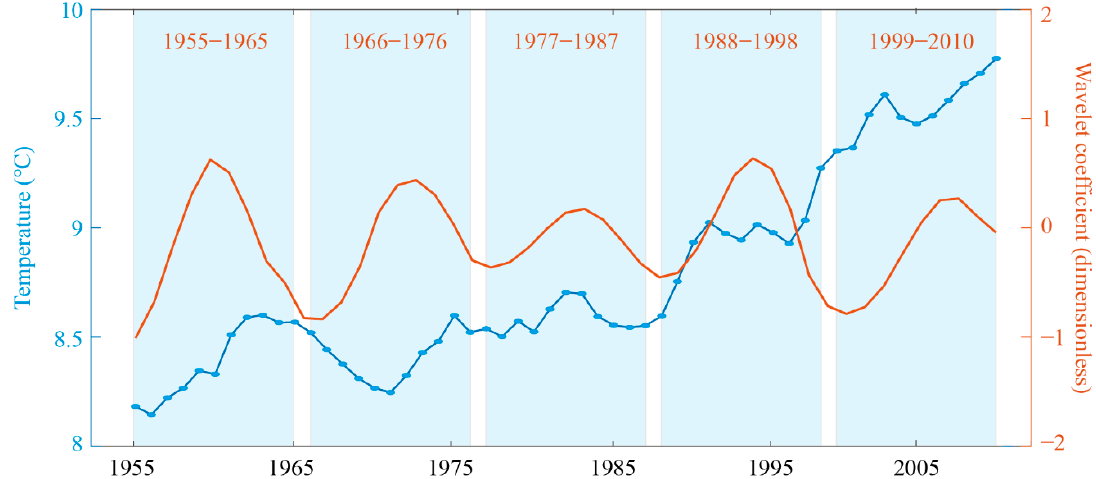
Figure 3. A comparison between the 5-YMAT (blue dotted curve) and the harmonic of the period of 11 years (orange curve). Blue areas indicate the division of the temperature time series into five cycles. Table 1. A list of the cycle periods in temperature time series with the rise and drop period (and duration) of each.